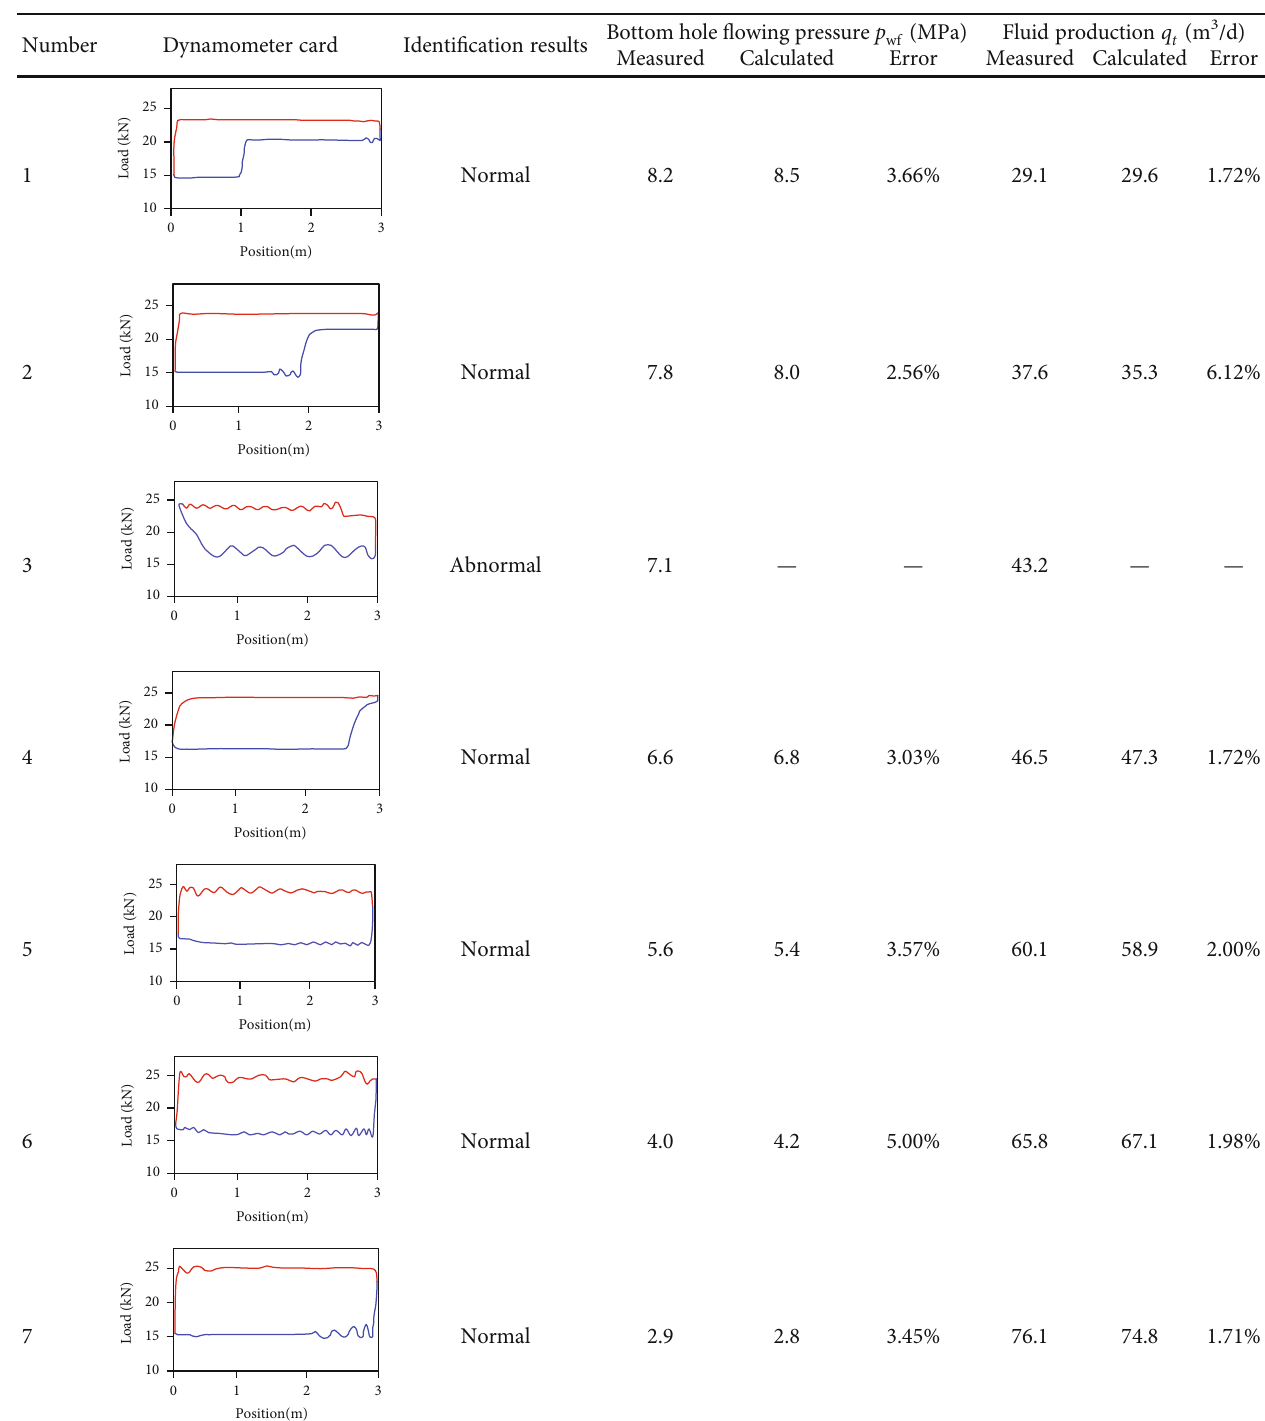
Table 1: Calculation